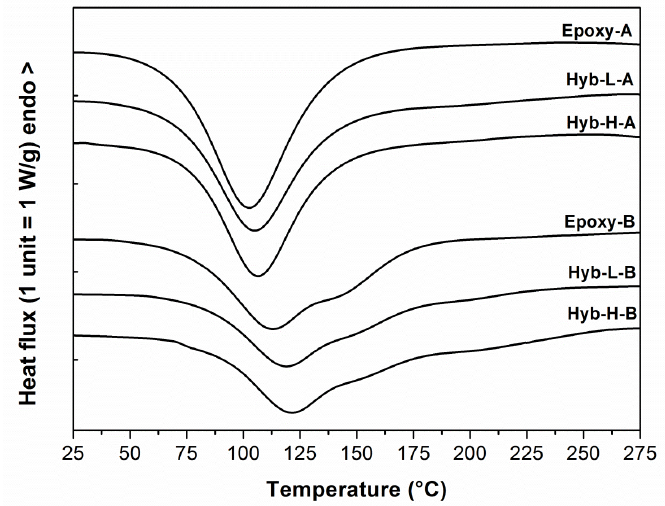
Figure 3. Dynamic DSC thermograms at 10 ◦ C/min of uncured epoxy systems as a function of DES content and curing agent typology.